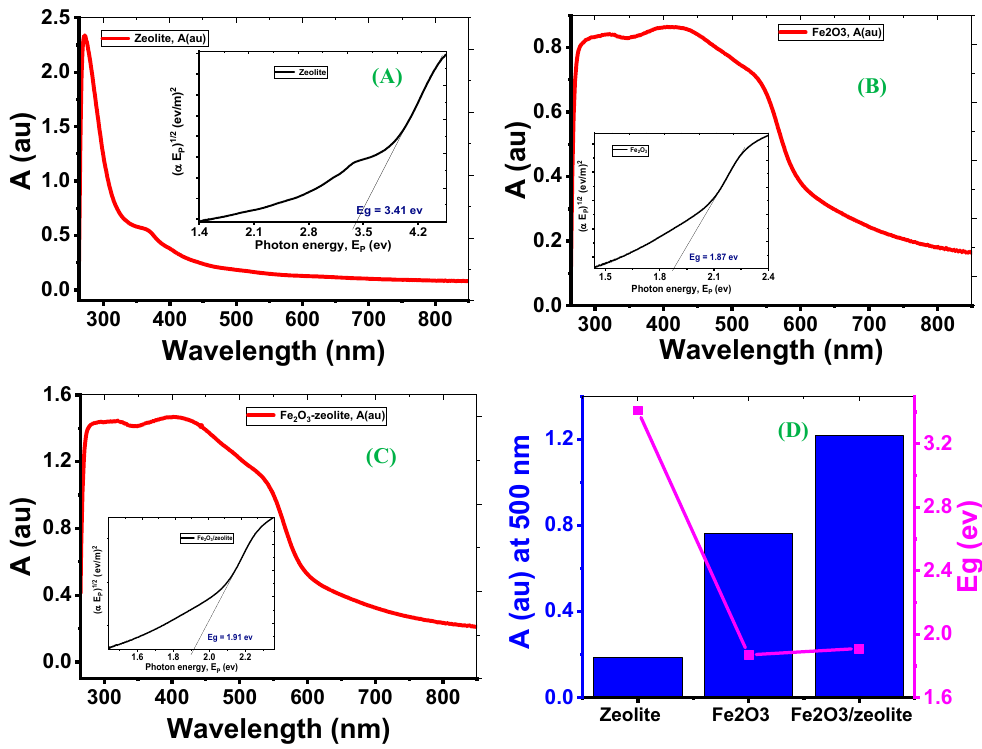
Figure 4. Absorbance and Tauc curve for zeolite ( A ), Fe 2 O 3 ( B ), and Fe 2 O 3 ‐ zeolite ( C ); and absorbance at 500 nm and indirect Eg for all samples ( D ).